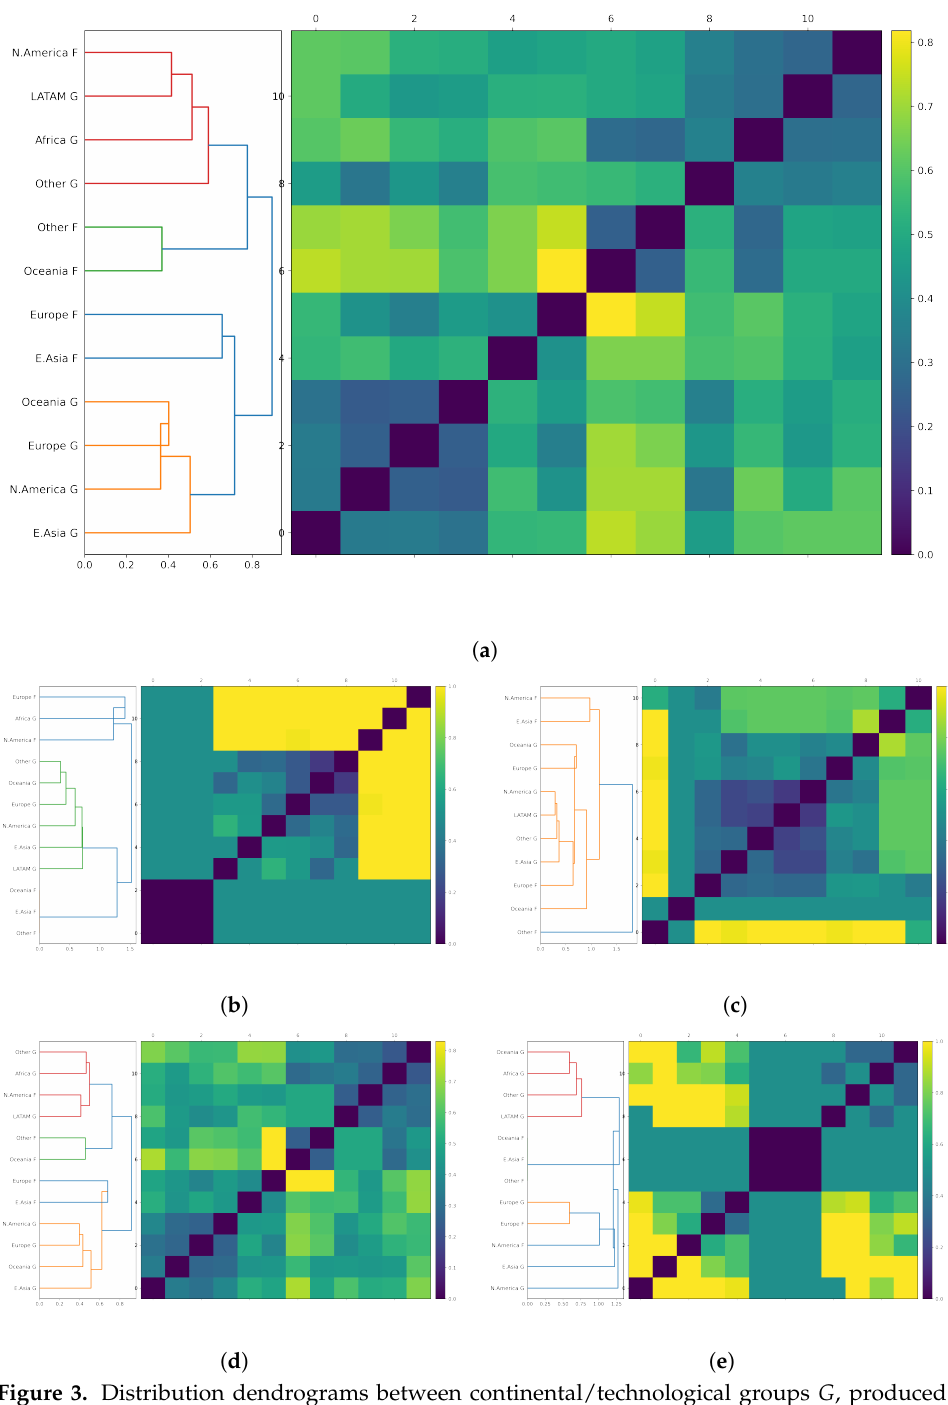
Figure 3. Distribution dendrograms between continental/technological groups G , produced by hierarchical clustering on the distance (2) for ( a ) the entire period of analysis ( b ) 2000—2009 Africa or Latin